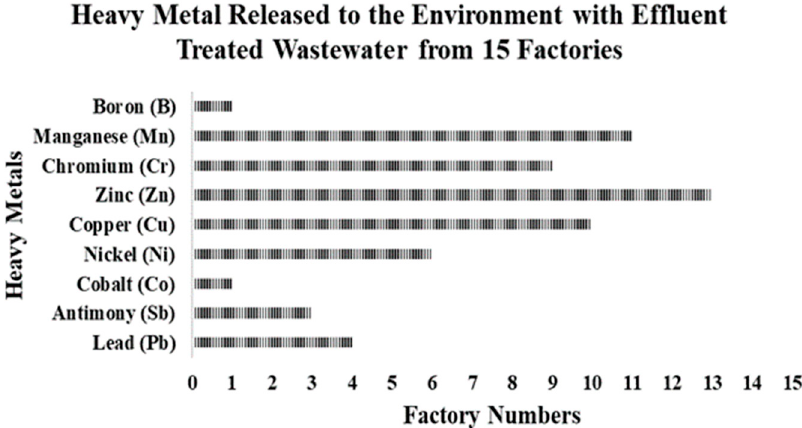
Figure 7. Heavy metal released with effluent-treated wastewater.